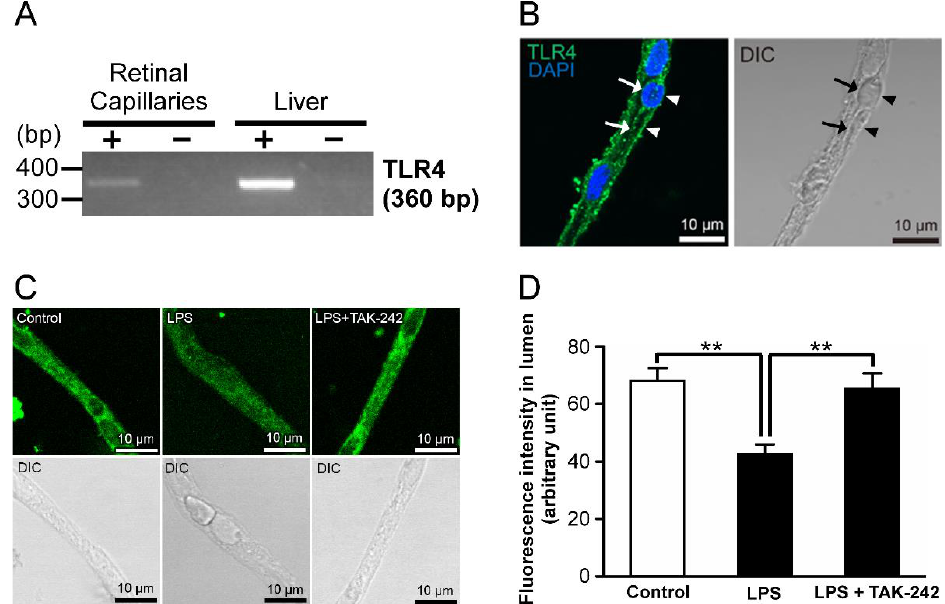
Figure 2. Relationship of toll-like receptor 4 (TLR4) with LPS-mediated P-gp attenuation in the retinal capillaries. ( A ) mRNA expression of TLR4 in rat retinal capillaries. RT-PCR analysis was performed in the presence (+) or absence ( − ) of reverse transcriptase using specific primers for TLR4. The rat liver was used as the positive control. ( B ) Localization of TLR4 proteins in rat retinal capillaries. Rat retinal capillaries were immunostained with anti-TLR4 antibodies (green). TLR4-derived immunoreactivities were observed on both the luminal (arrows) and abluminal (arrowheads) membranes of the rat retinal capillary. The nuclei were stained with DAPI (blue). Capillary images were captured using a LSM900. ( C , D ) Effect of TAK-242 (TLR4 inhibitor) on luminal NBD-CSA transport in rat retinal capillaries. ( C ) Representative confocal images of isolated rat retinal capillaries after incubation with 4 µM NBD-CSA for 60 min. The capillaries were preincubated with 1 ng/mL LPS in the absence or presence of TAK-242 at 1 µg/mL for 30 min. ( D ) Quantification of NBD-CSA fluorescence in the lumens of the retinal capillaries. Each column represents the mean value for 10 capillaries from a single preparation; variability is given by S.D. bars. Units are expressed as arbitrary fluorescence (scale 0 – 255). ** p < 0.01, significantly different between the groups. Capillary images were captured using a TCS-SP5.